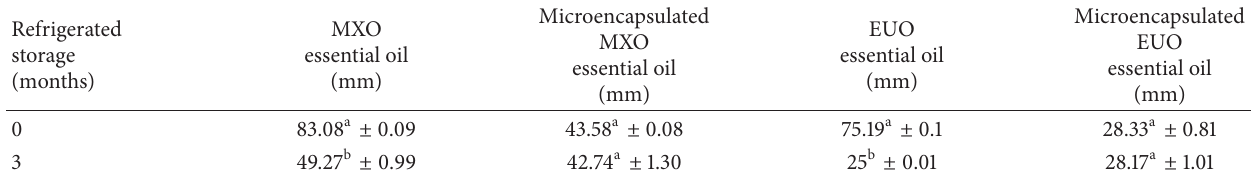
Table 6: Stability of free and microencapsulated Lippia graveolens H.B.K. and Origanum vulgare L. essential oils at 25% at 4 ∘ C. Antimicrobial activity is shown as inhibition zone (mm) using Micrococcus luteus